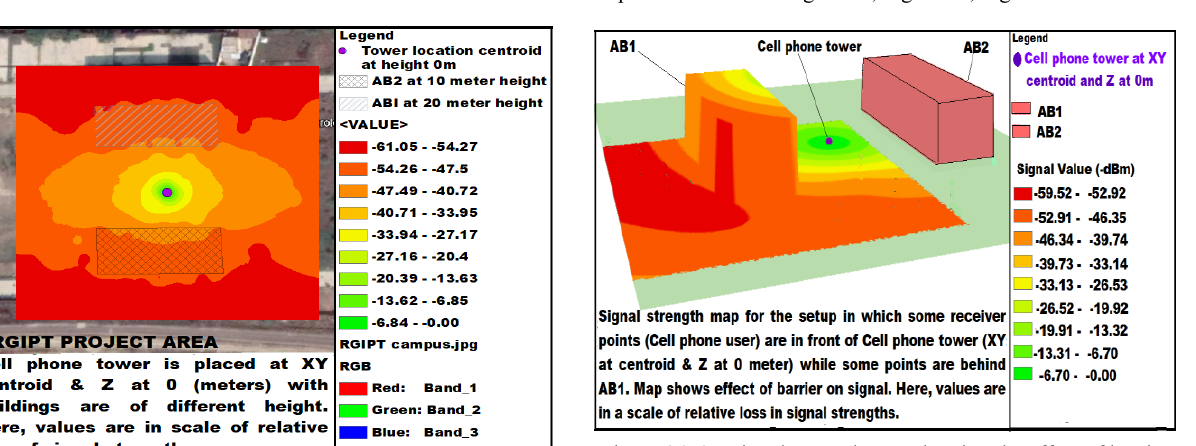
Figure 20. Cell phone tower at XY Centroid and Z at 24 meters. Step2- In this step, the second case is taken when AB1 is at 20- meter height and AB2 is at 10-meter height. Now for this setup, the cell phone tower is placed at XY centroid and varying height at 0-meter, 10-meter, and 20-meter. The signal strength map is created for each height shown in Figure 20, Figure 21, Figure 22.